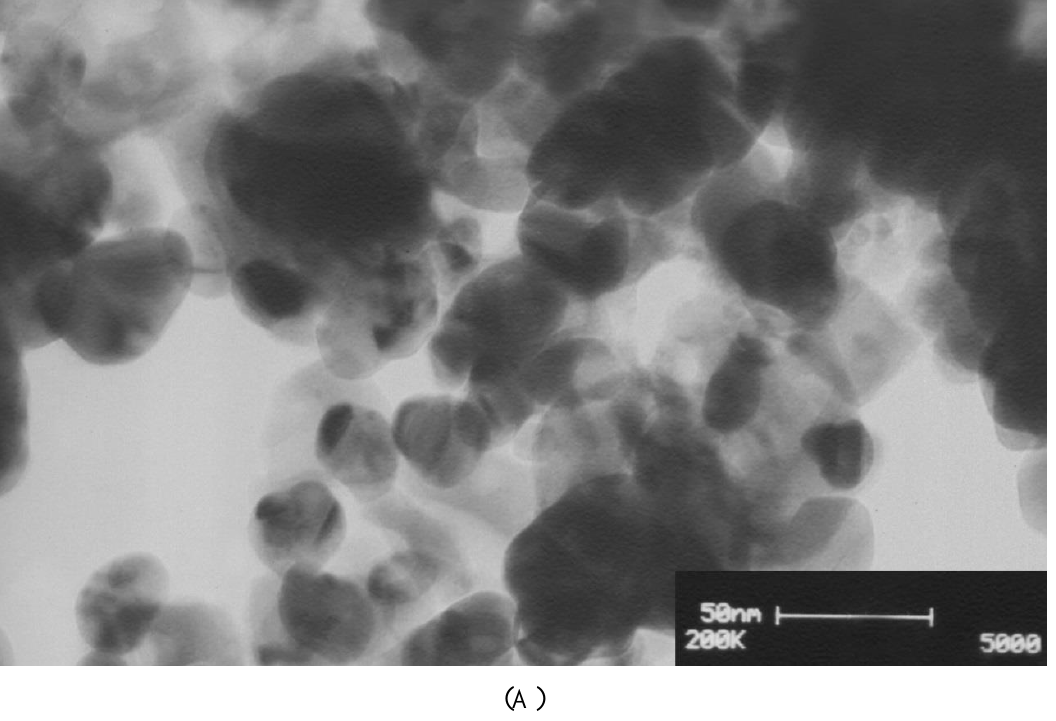
Figure 2. ( A ) The FTIR spectrum and ( B ) the XRD pattern of biosynthesized AgCl-NPs using aerial part extracts of the P. vulgaris plant.